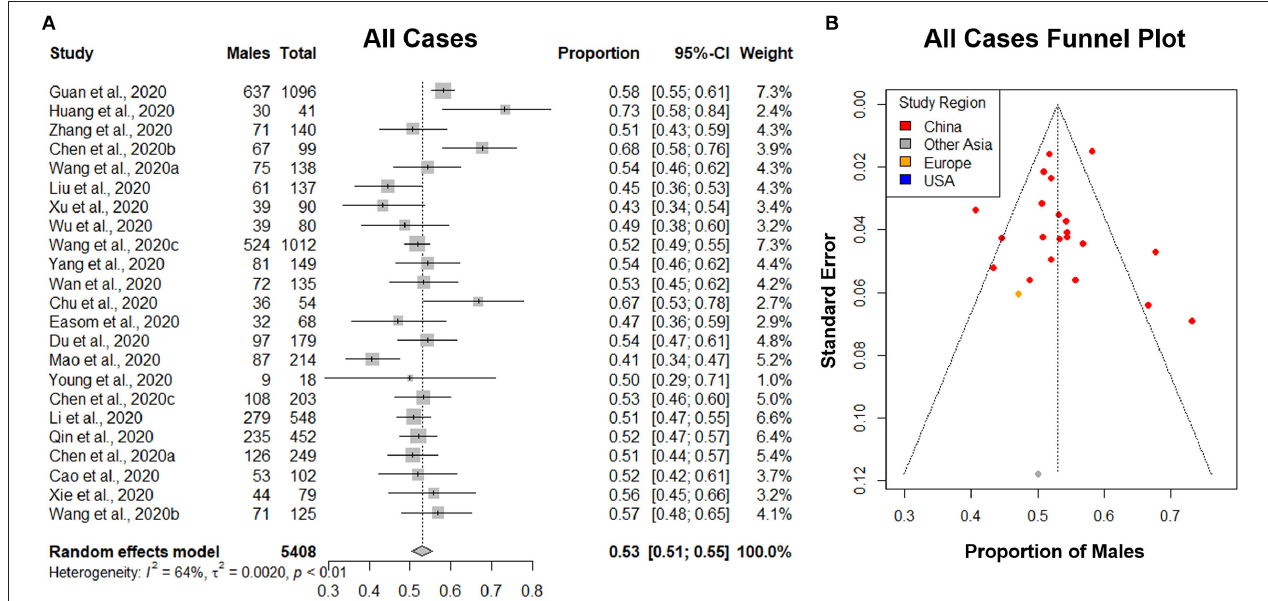
FIGURE 4 | The proportion of males in all lab-confirmed COVID-19 cases. (A) Forest plot of sex-distribution in all lab-confirmed COVID-19 cases in each of the studies. Proportions of males and the 95% confidence intervals (CIs) are indicated. The vertical dotted line represents the combined proportion of all studies. The diamond represents the combined 95% CI, the left and right endpoints of which are the lower and upper bounds of the CI, respectively. (B) Funnel plot with 95% confidence region of sex-distribution in all lab-confirmed COVID-19 cases in each of the